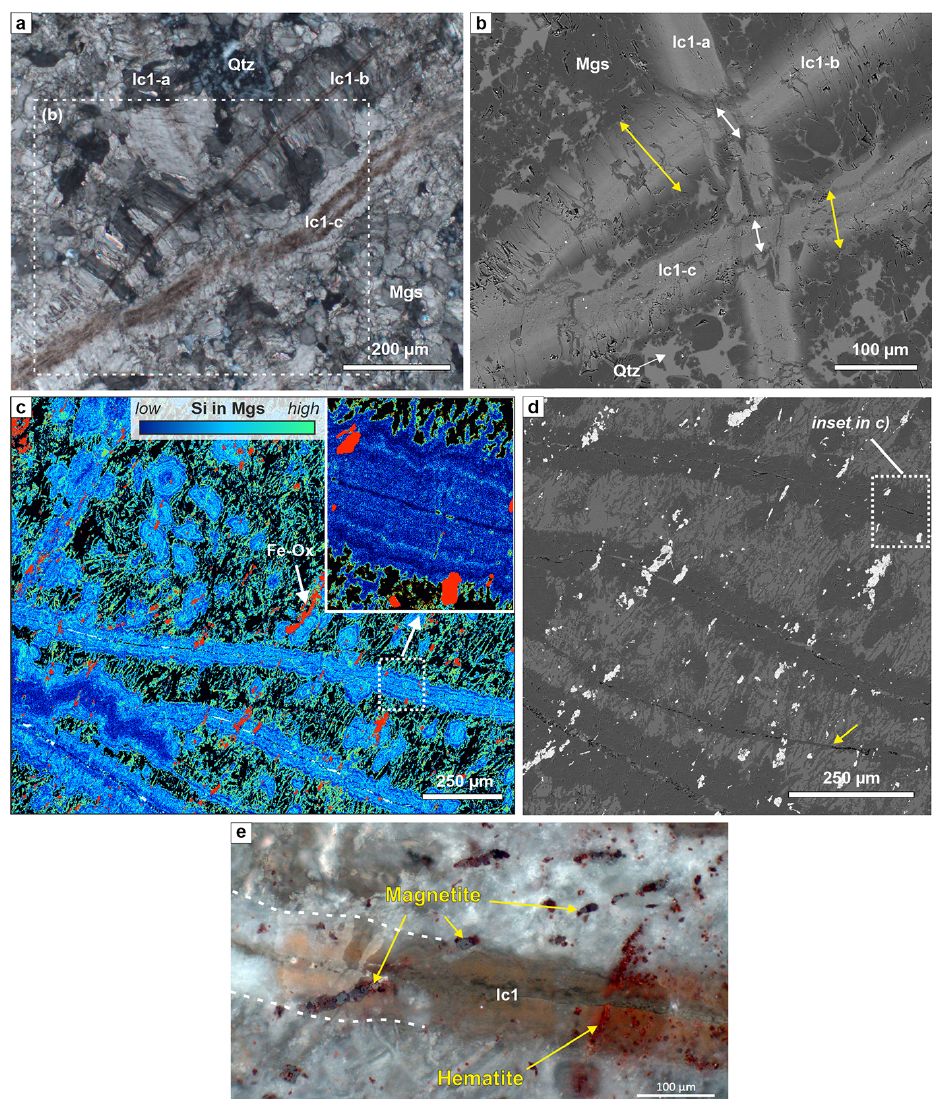
Figure 8. Microstructures showing the extent of opening versus host-rock replacement by zoned magnesite veins. (a) Different generations of zoned magnesite veins with a brown, Fe-enriched median zone, showing fibrous (lc1-a, lc1-b) and wide-blocky (lc1-c) habits (xpol). (b) BSE image of the area marked in (a) , showing that the true vein aperture via opening at the intersection with the earlier vein lc1-a corresponds to inclusion-bearing median zones only (white arrows), while fibrous to euhedral overgrowths indicate that a significant fraction of the total vein thickness (yellow arrows) must have formed due to replacement of the host rock (BT1B_14-1_7-11). (c) Si content in magnesite from EDX mapping (with Fe oxides in red; quartz – black; minor dolomite – white), showing vein-parallel zoning in carbonate veins and concentric zoning in matrix magnesite ellipsoids. Only the median zone of veins cuts the oblique Fe oxides. Local folding of an Si-poor vein core in the lower left. (b) BSE image of part of the area in (c) ; the yellow arrow marks a thin vein that did not develop the common replacement rim. (e) Crossed polarized, reflected light image of the relationship between a wide-blocky zoned magnesite vein (lc-1), magnetite, and hematite. (c, d, e)